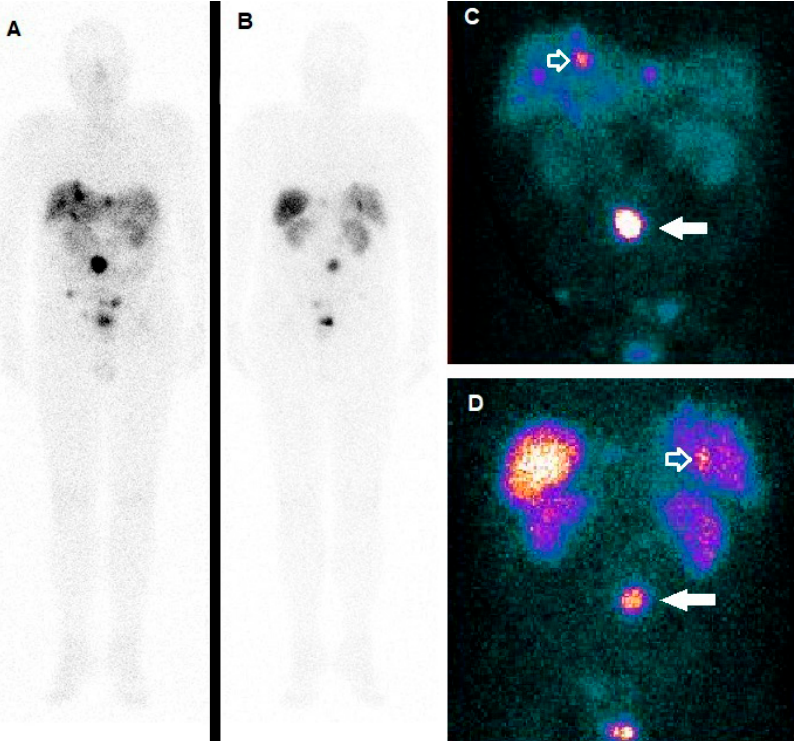
Figure 3. A 17-year-old male with mental retardation due to perinatal hypoxia, suffering from carcinoid syndrome due to ileal NET with hepatic metastases. Since symptomatology persisted despite somatostatin analog therapy and CT gave evidence of tumor progression, PRRT with 177Lu-DOTATATE was considered. Whole Body scan in anterior ( A ) and posterior ( B ) view, as well as the planar ( C , anterior; D , posterior), acquired with gamma camera centered on the 177 Lu photopeak at 113 KeV, well-demonstrated tracer incorporation both in the tumor ( C , D , white arrow) and in the liver lesions ( C , D , white-bordered arrow). Three further focuses of increased accumulation of the radiopharmaceutical are visible under the primary tumor in the pelvic region, especially evident in the anterior view ( C ), to be referred to peritoneal carcinomatosis.